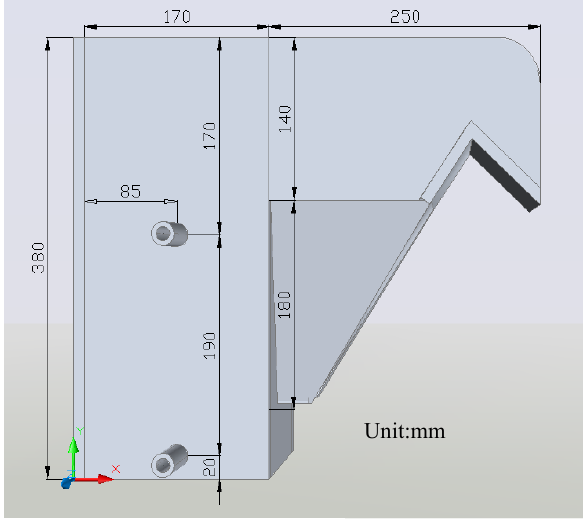
Figure 4. Diagram of the designed special flotation cell.